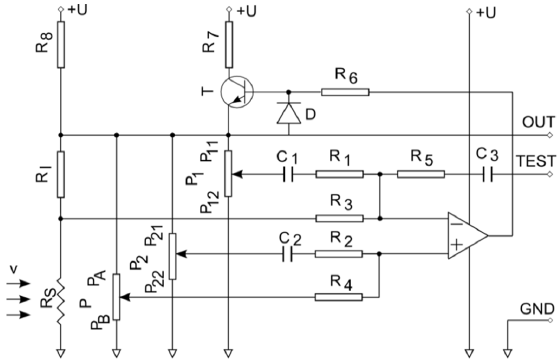
Figure 2. The simplified model of hot-wire anemometer featuring the optimization of bandwidth Figure 2. frequency.